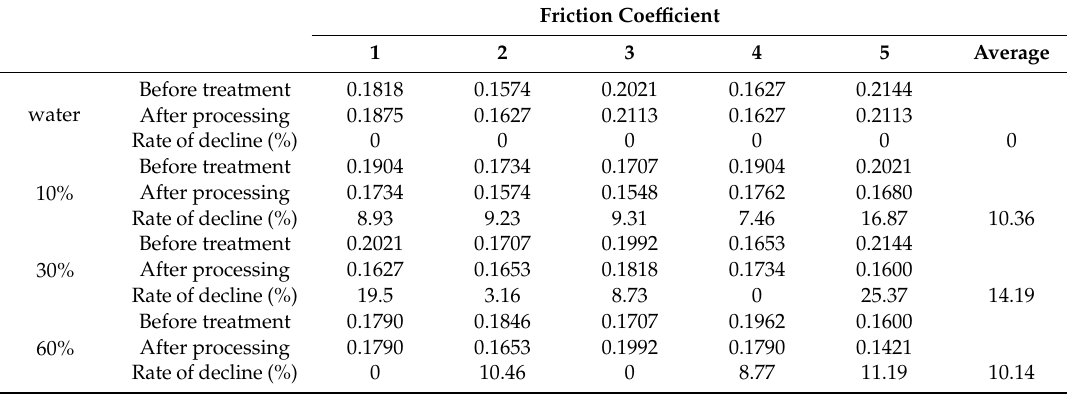
Table 4. Friction coe ffi cient of cotton after processing by diluted AES-PFPE emulsion.